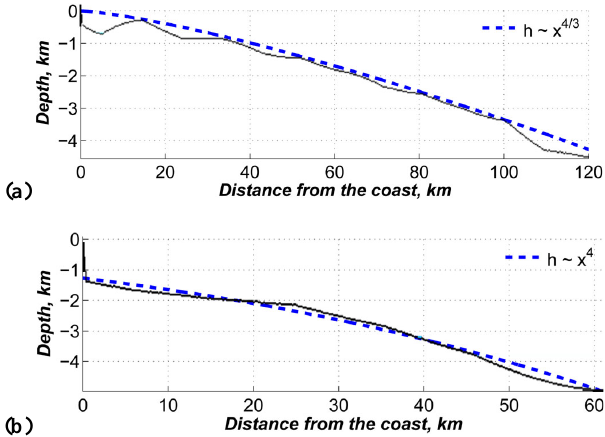
Fig. 1. Bottom profiles near Guadeloupe, Caribbean Sea (solid line) and their “non-reflecting” approximations (dashed line); (a) Marie- Galante and (b) La